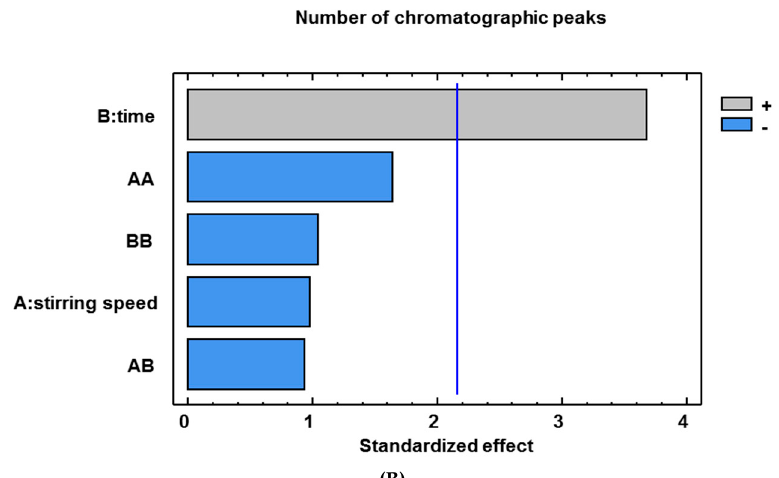
Figure 1. Pareto charts for total chromatographic area (A) and number of chromatographic peaks (B) as experimental responses.